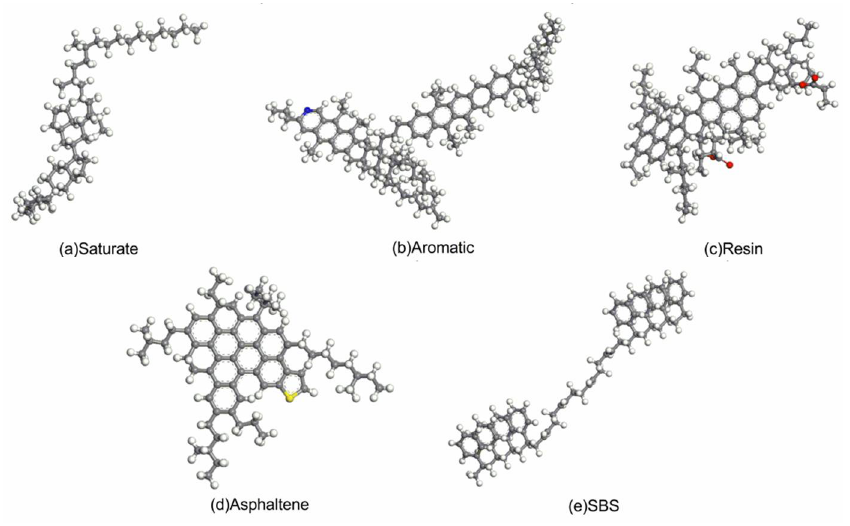
Figure 1. Five initial molecular models: ( a ) saturate; ( b ) aromatic; ( c ) resin; ( d ) asphaltene; ( e ) SBS. SBS is a triblock copolymer composed of PS and PB [12]. Because the actual molecular weight was too large, the calculation was beyond the scope of computing power, and the focus of this article was to study the interface interaction and the reaction between SBS and asphalt, so SBS was simplified. A linear SBS molecule with an S/B ratio of 4:4 was selected as the polymer modifier. The structure of the constructed SBS molecule is shown in Figure 1e, and the molecular formula is C 80 H 90 .